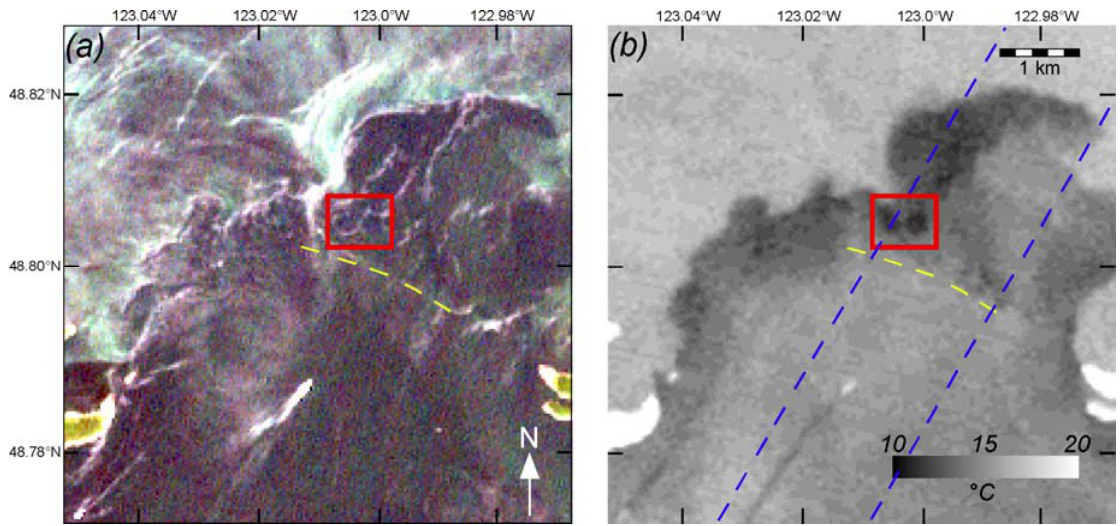
Figure 3. LANDSAT Enhanced Thematic Mapper Plus (ETM+) imagery over the area in Figure 1(b). Imagery acquired at 1853 UTC 28 June 2000. ( a ) Visible imagery; red box highlights two boils; ( b ) Thermal imagery; temperature scale is approximate. Dashed blue lines as in Figure 1(b). The sill crest only is indicated (dashed yellow curve) as the full set of isobaths masks features of interest. Oppositely-traveling ships appear in the lower left of each